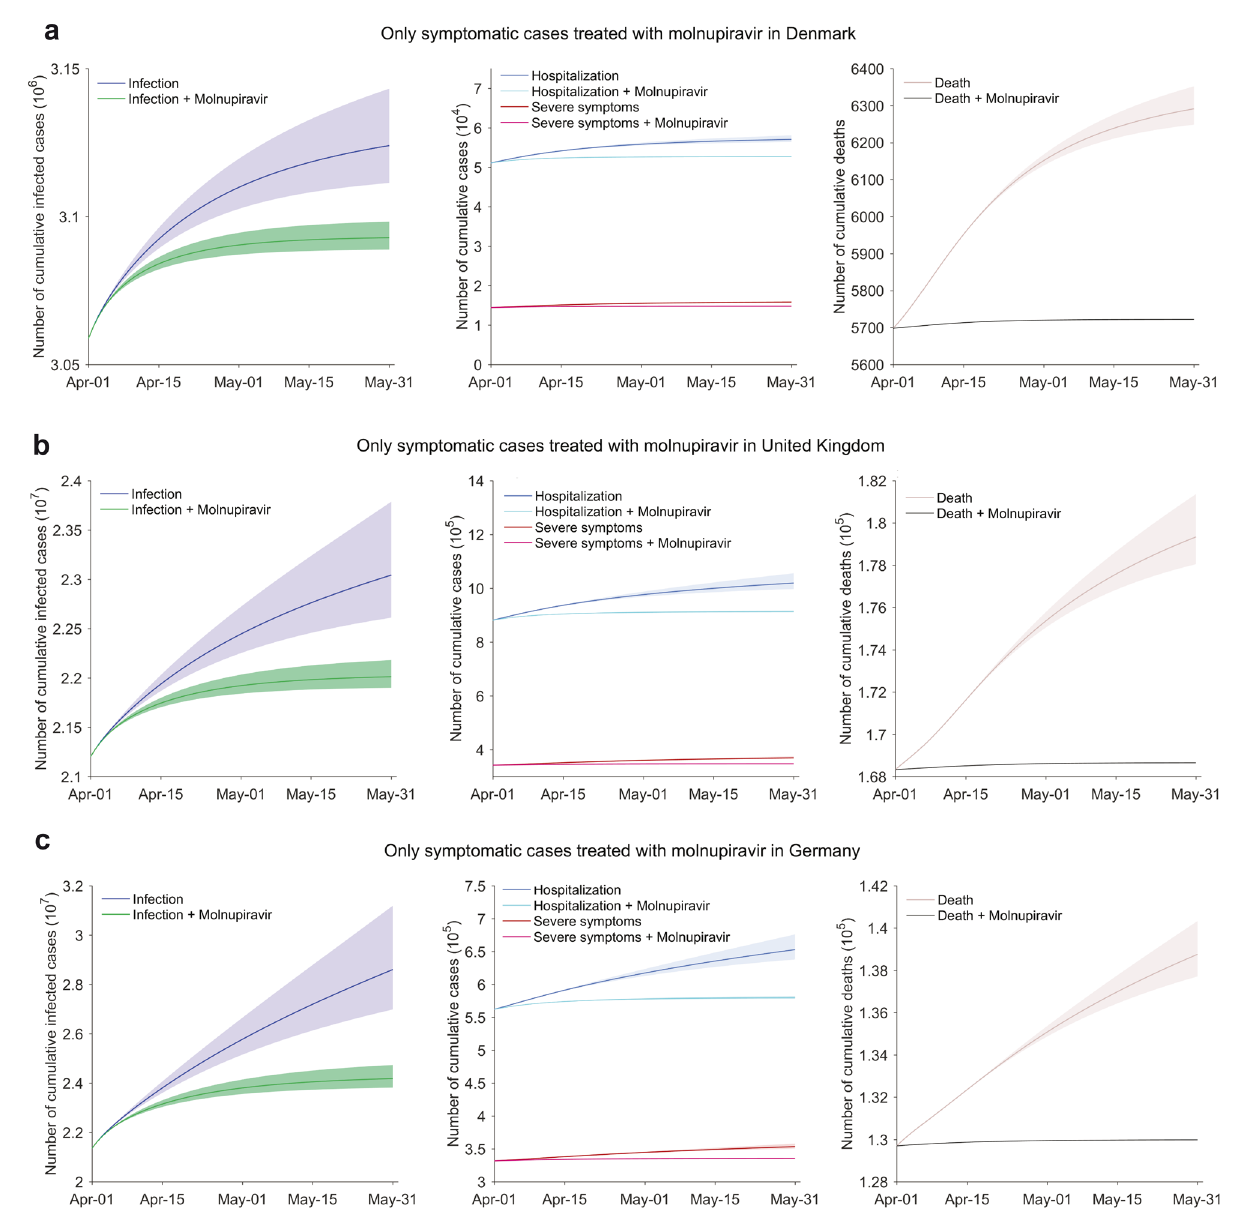
Figure 5. The impact of molnupiravir treatment for nonhospitalized patients with symptoms. ( a ) Denmark. ( b ) UK. ( c ) Germany. Treatment with molnupiravir after the onset of symptoms in nonhospitalized cases. The settings of social activity level, the reinfection proportion, dominating pango lineages, the treatment implementation time, and the molnupiravir treatment effectiveness for individuals are identical to those in Fig. 4. The shadow parts represent the 95% confidence interval related to